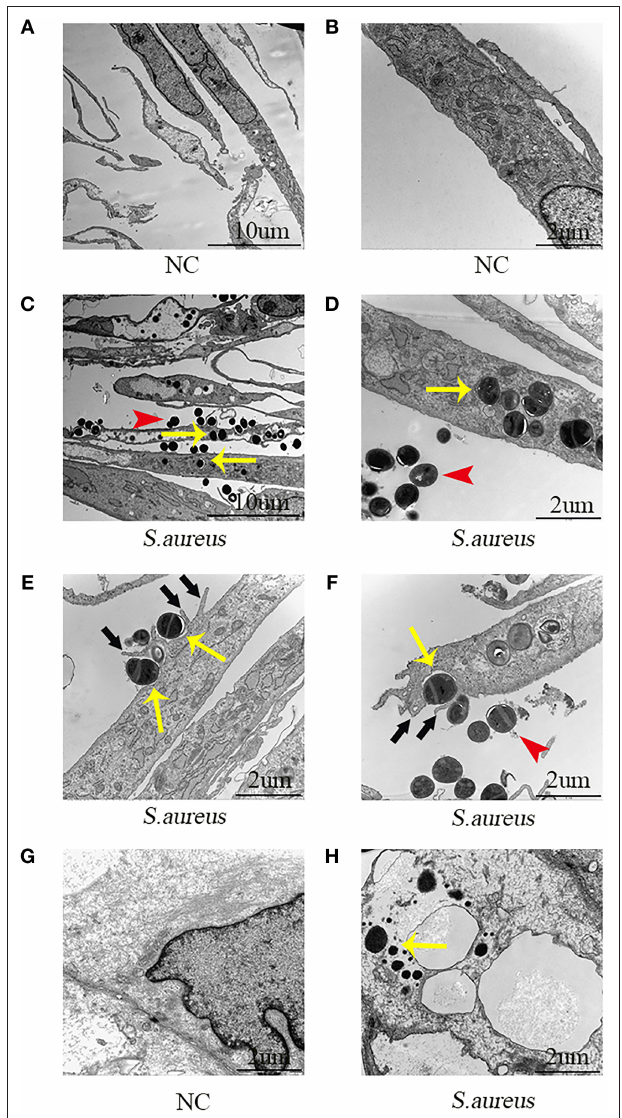
FIGURE 2 | Electron microscopic images of NPCs phagocytizing S. aureus in vivo and in vitro . (A,B) NPCs without incubation with S. aureus were characterized by a large rod nucleus and a thin rim of agranular cytoplasm. (C,D) After co-culturing the NPCs with S. aureus for 4h, ingested S. aureus (yellow arrow) was observed in the phagosome within the cytoplasm of NPCs and extracellular S. aureus was found (red arrow ). (E,F) There were a varying number of membrane protrusions (black arrows) tightly engulfing S. aureus (yellow arrows). (G,H) Compared with NPCs without incubation with S. aureus , ingested S. aureus (yellow arrow) were observed in the cytoplasm of NPCs after caudal IVD infection with S. aureus for 4h in vivo . All micrographs are represented at least three